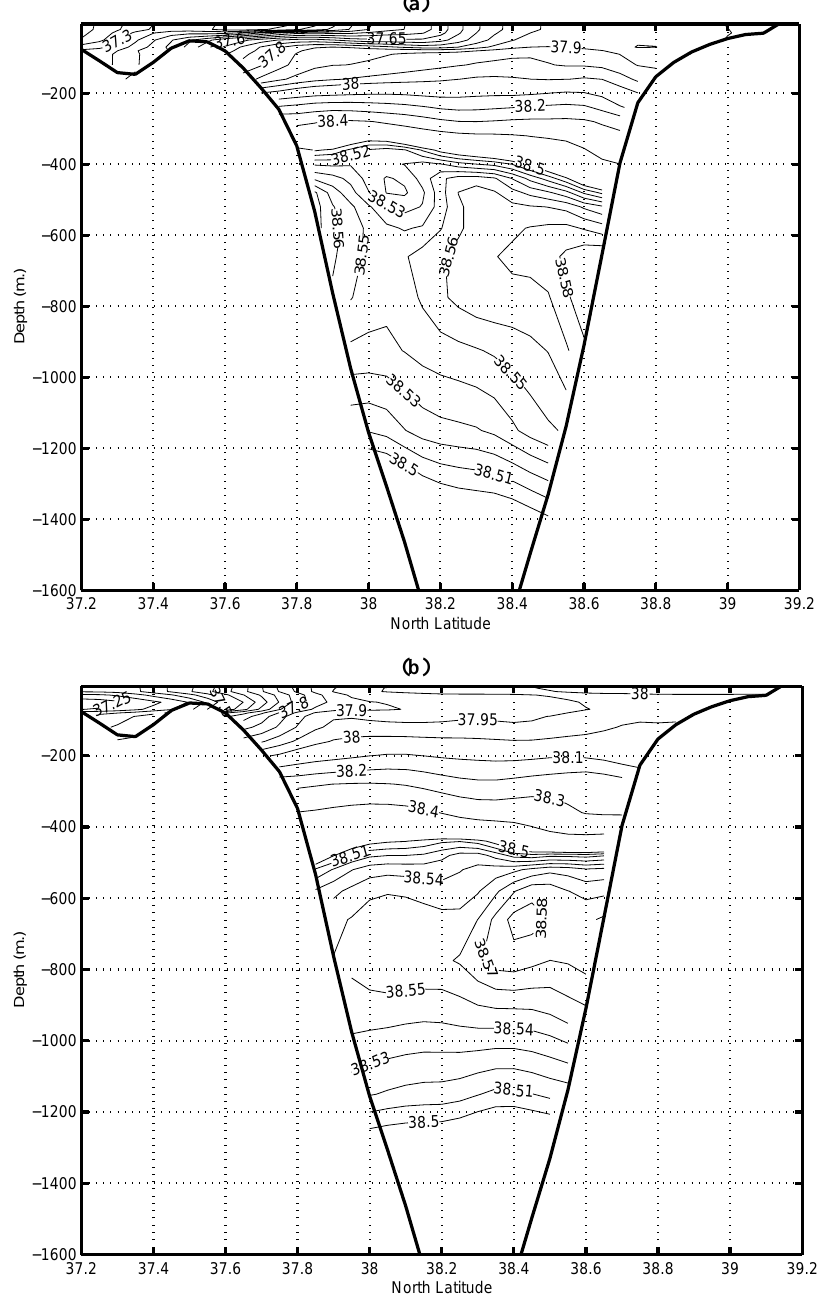
Fig. 14. The simulated 10-day averaged vertical section of salinity along longitude 9 ◦ E in (a) February and (b) August. The contour interval is 0.05psu in the range 37.0 to 38.5psu, 0.01 in the range between 38.0 to 38.5 and 0.02 in the range 38.5 to 38.6psu. layer width and core depth. The vertical sections of the